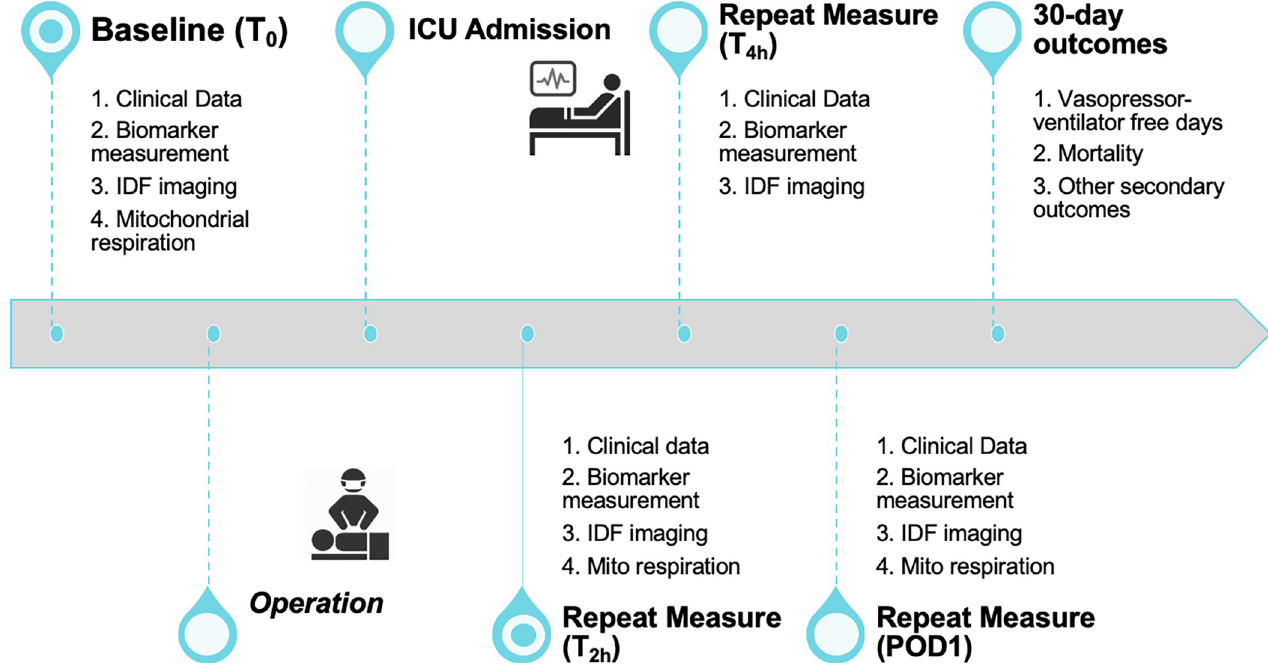
Fig 1. Timeline of data